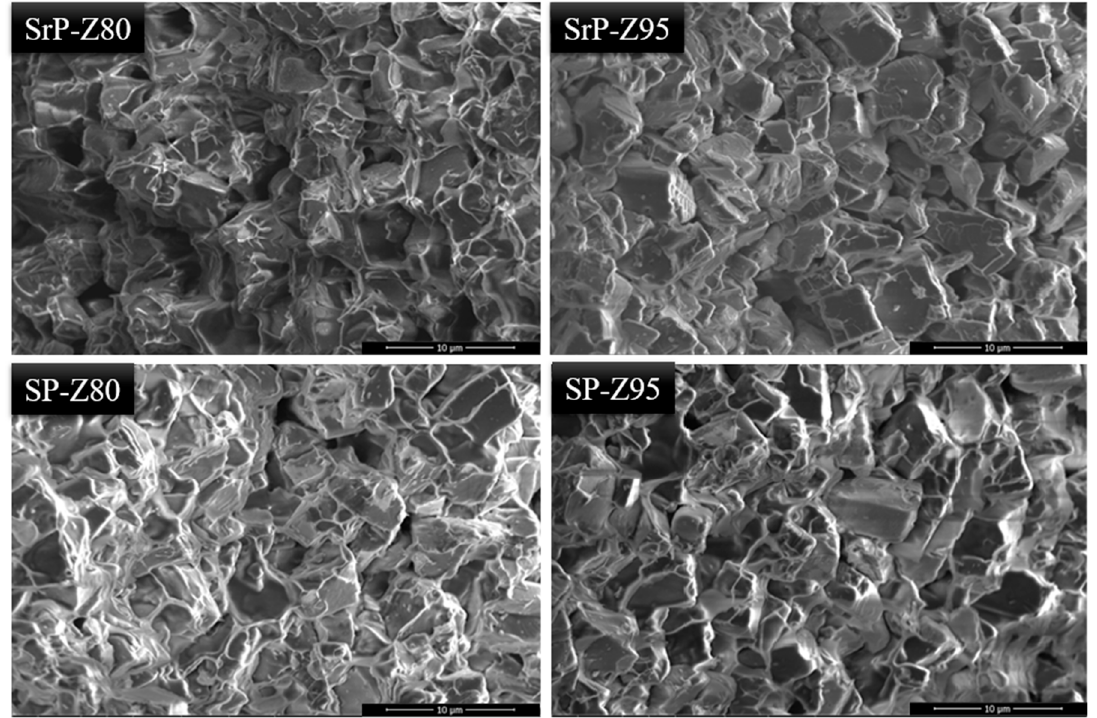
Figure 8. SEM micrographs of fracture surfaces in S-PEEK and S-rPEEK coating at different zeolite content (80 and 95%).